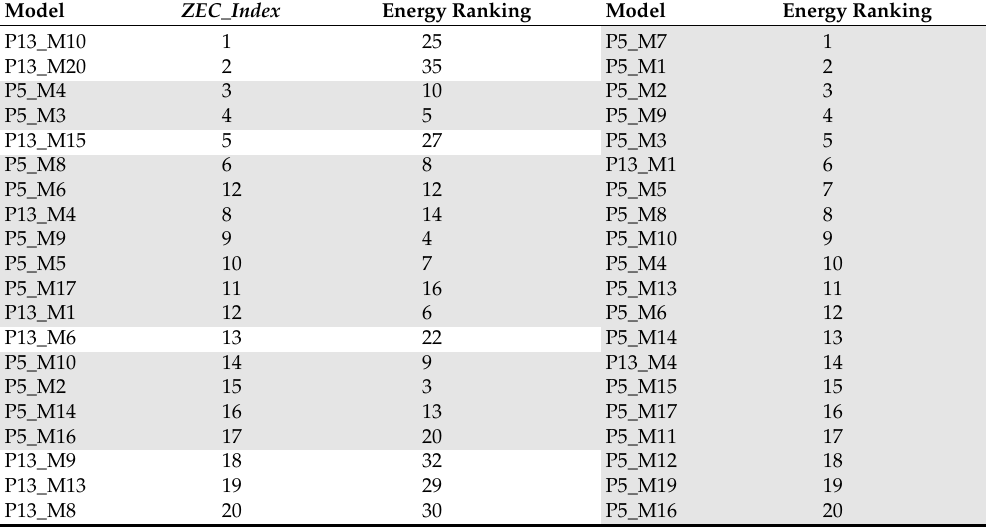
Table 9. (Synthetic case) On the left of the table, ranking ascending by ZEC _ Index and with reference to its energy position. On the right, ranking ascending by energy. The shaded text corresponds to the 20 best energy models.